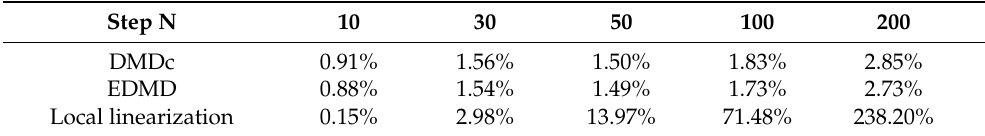
Table 4. RMSEs of deviations between the real states and the predicted states with different methods (Scenario